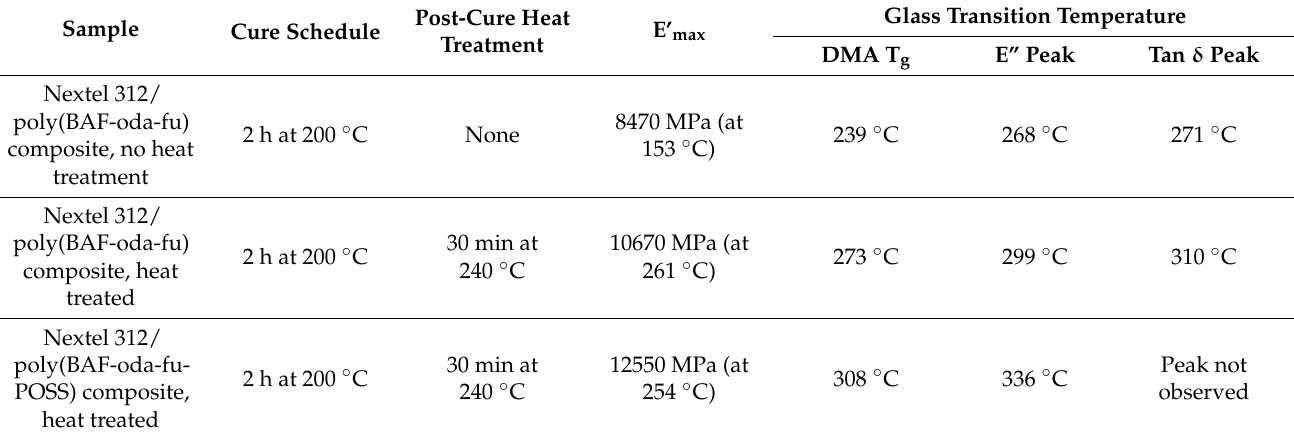
Table 1. Summary of Dynamic Mechanical Analysis